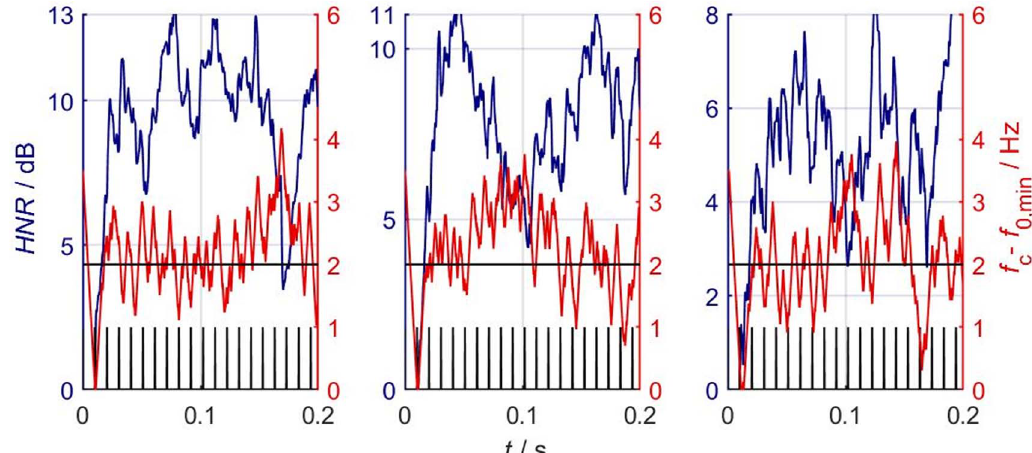
Figure 6. IRN with 5, 3 and 1 iterations (left to right panels, simulation V). Data presentation is as in Figure 3. The estimate converges quickly to the target value of 98 Hz (+2 Hz on the relative frequency scale). The HNR decreases with less iterations and shows some variance, but the fundamental frequency estimate is still quite